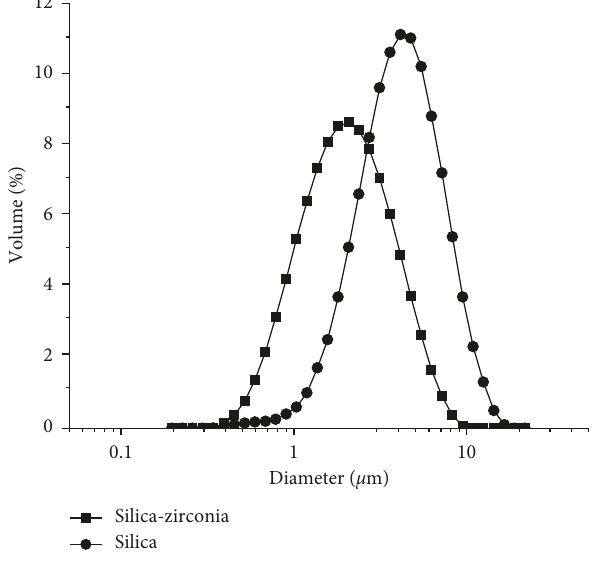
Figure 5: Particle size distribution of the